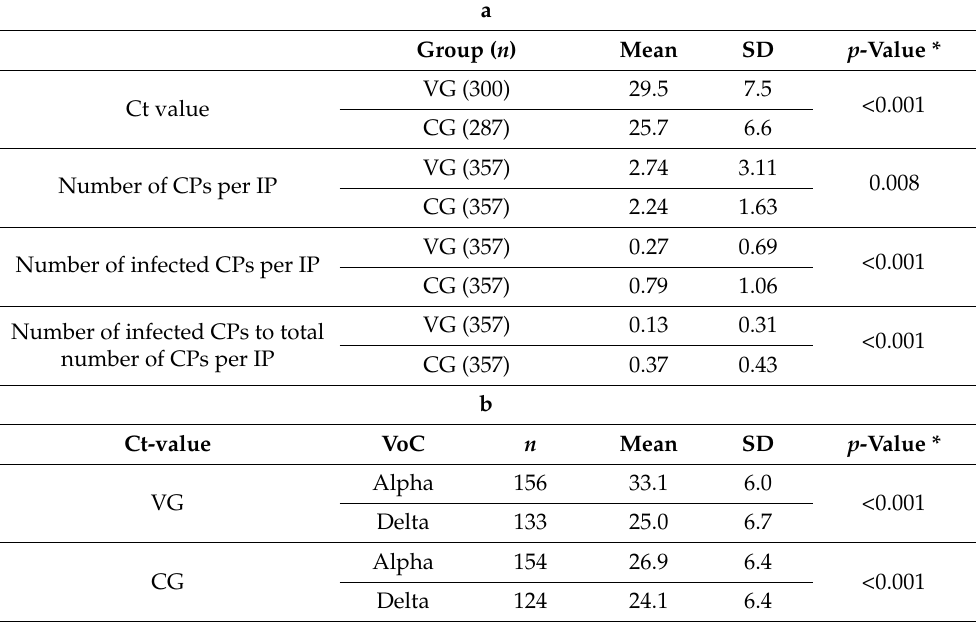
Table 2). The Ct value was significantly higher in the VG at 29.5 ± 7.5 than in the CG at 25.7 ± 6.6 ( p < 0.001; Table 2) and lower in patients infected with the Delta variant (Table 2). Table 2. a: Ct value (cycle threshold value), total CPs (contact persons) per IP (index person), infected CPs total and in relation to total CPs per IP in VG versus CG. * unpaired t -test. b: Differences between the Ct-value (cycle threshold value) in the VG (vaccinated group) and CG (control group) regarding the Alpha and Delta variants. Wild type and Beta were excluded because of their small numbers. * unpaired t